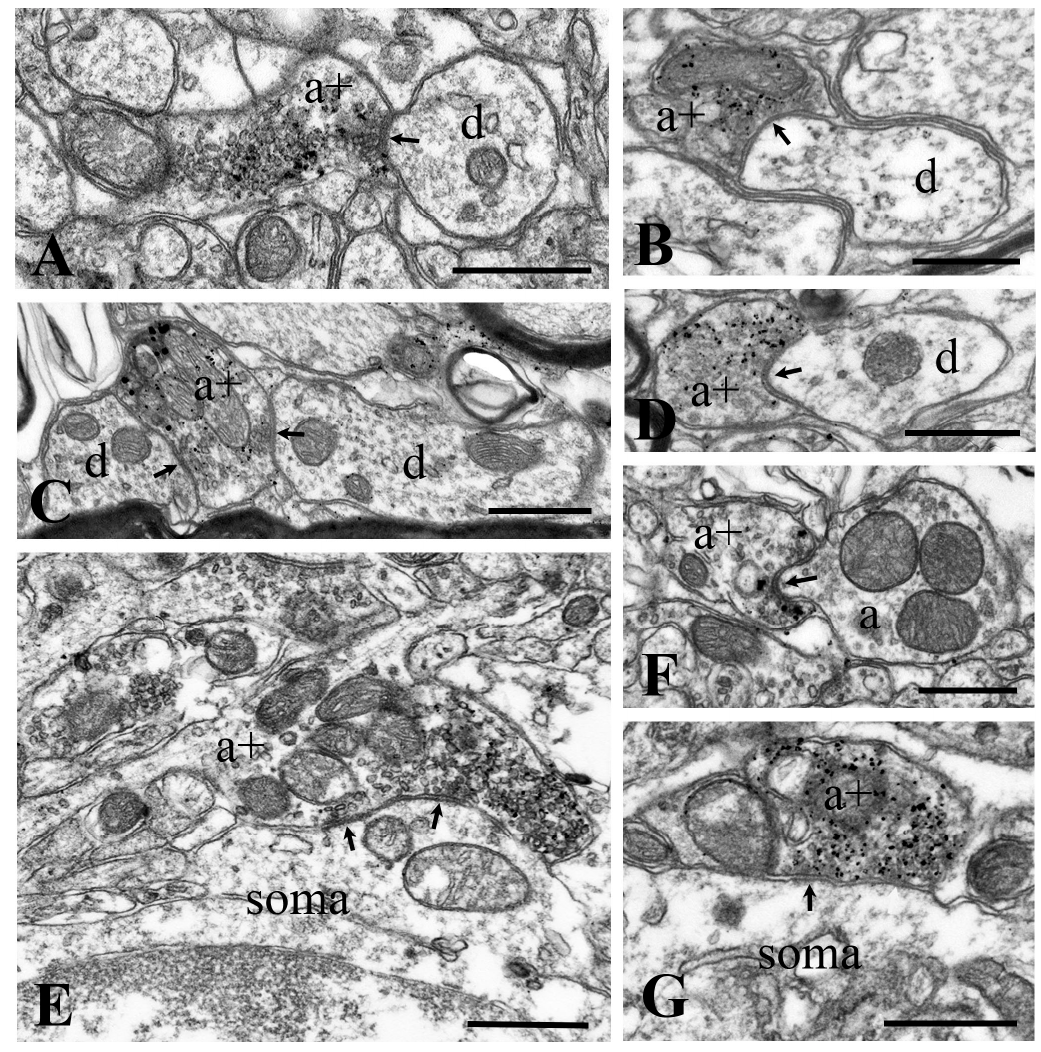
Figure 3. Synapses made by GlyT2 immunostained axon terminals. Electron micrographs showing axo-dendritic ( A – D ), axosomatic ( E , G ), and axo-axonic ( F ) synaptic contacts made by GlyT2 immunostained axon terminals in laminae I–III of the superficial spinal dorsal horn at the L4–L5 level of the spinal cord. GlyT2 immunoreactivity appears as accumulated gold particles at perisynaptic locations and is distributed over synaptic vesicles. a+: axon terminals immunostained for GlyT2, d: postsynaptic dendrites, soma: postsynaptic perikarya, and a: postsynaptic axon. Arrows point to synaptic appositions. Bars: 0.5 µ